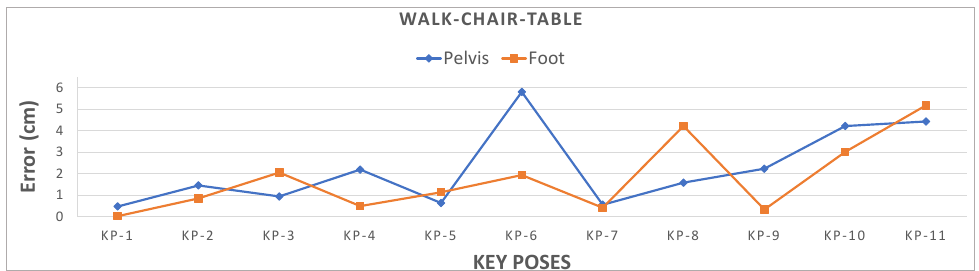
Figure 9. Accuracy for selected pelvis and right foot key